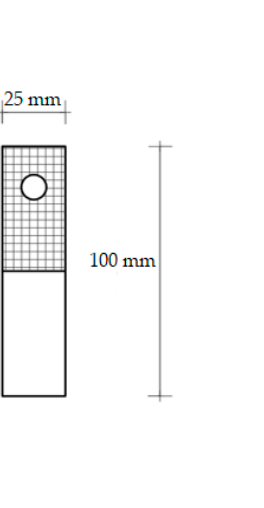
Figure 1. ( a ) Sketch of the sample for ice adhesion testing and ( b ) testing machine with a mounted sample.